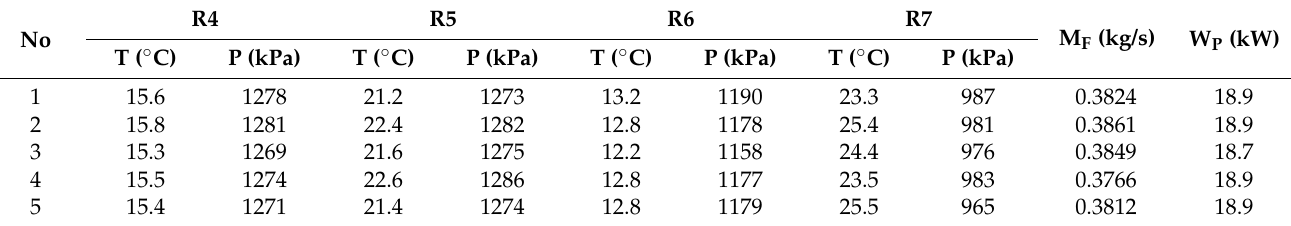
Table 17. Refrigerant side measurement result (five